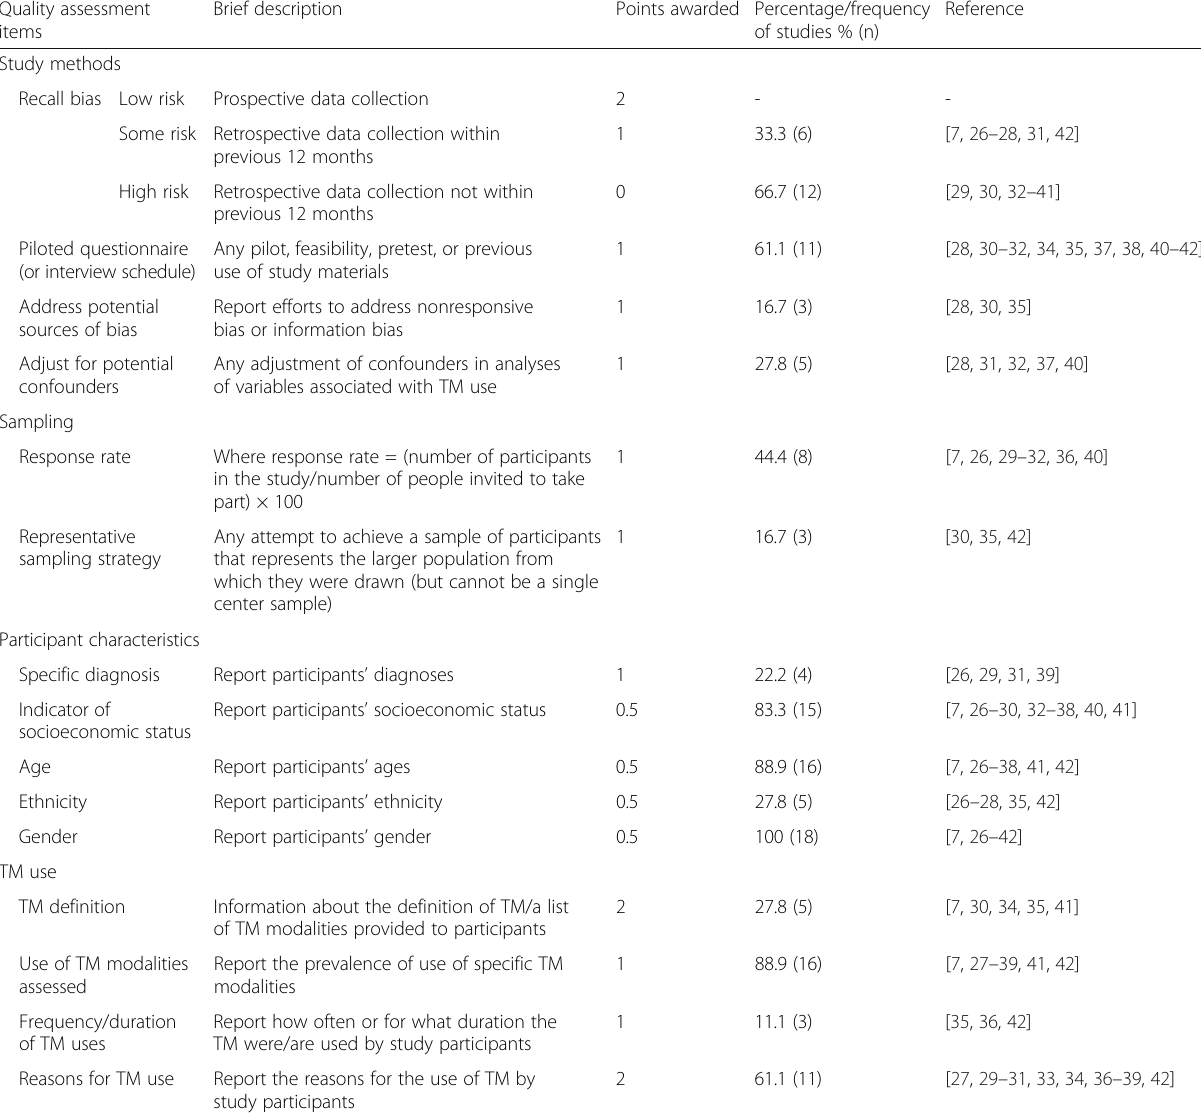
Table 1 Summary of the quality of studies Quality assessment